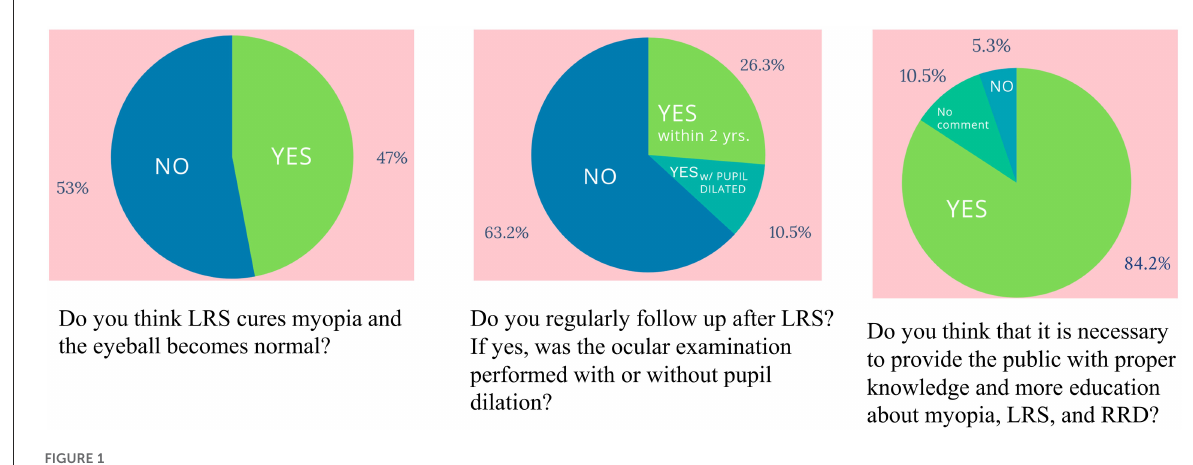
FIGURE1 The result of the questionnaire about eye care knowledge and attitude toward myopia and laser refractive surgery.